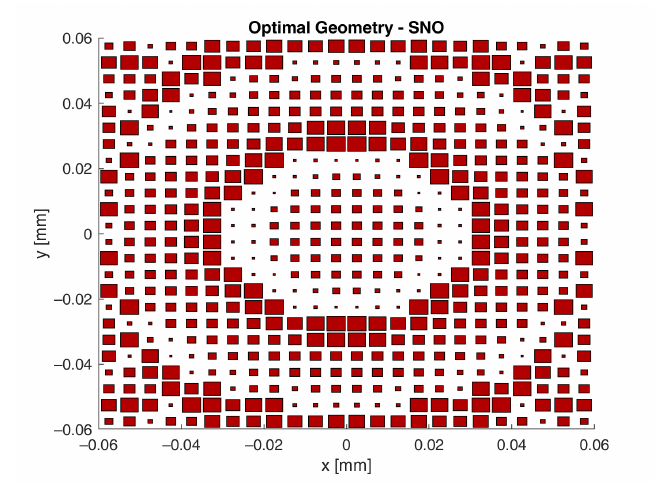
Figure 9. Optimal geometry obtained by SNO.